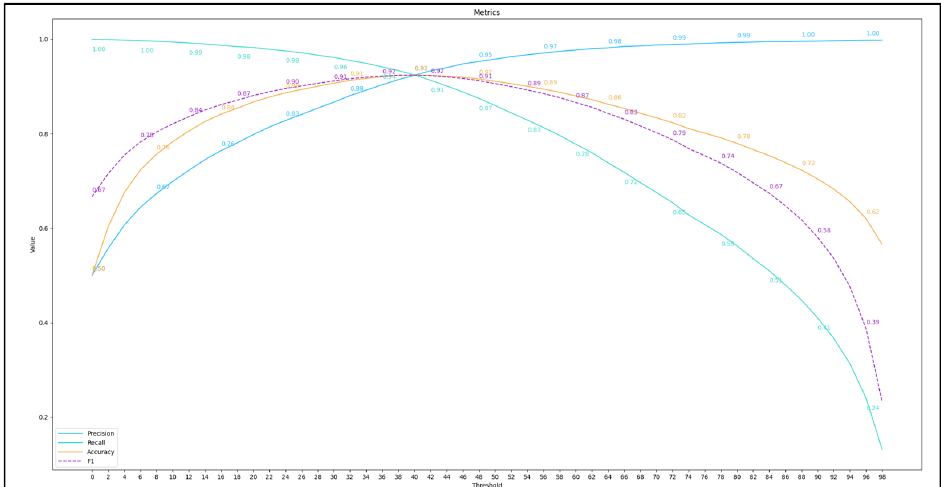
Figure 7. Maximum F1 score reached on an optimized ensemble with the best model (threshold = 0.393).